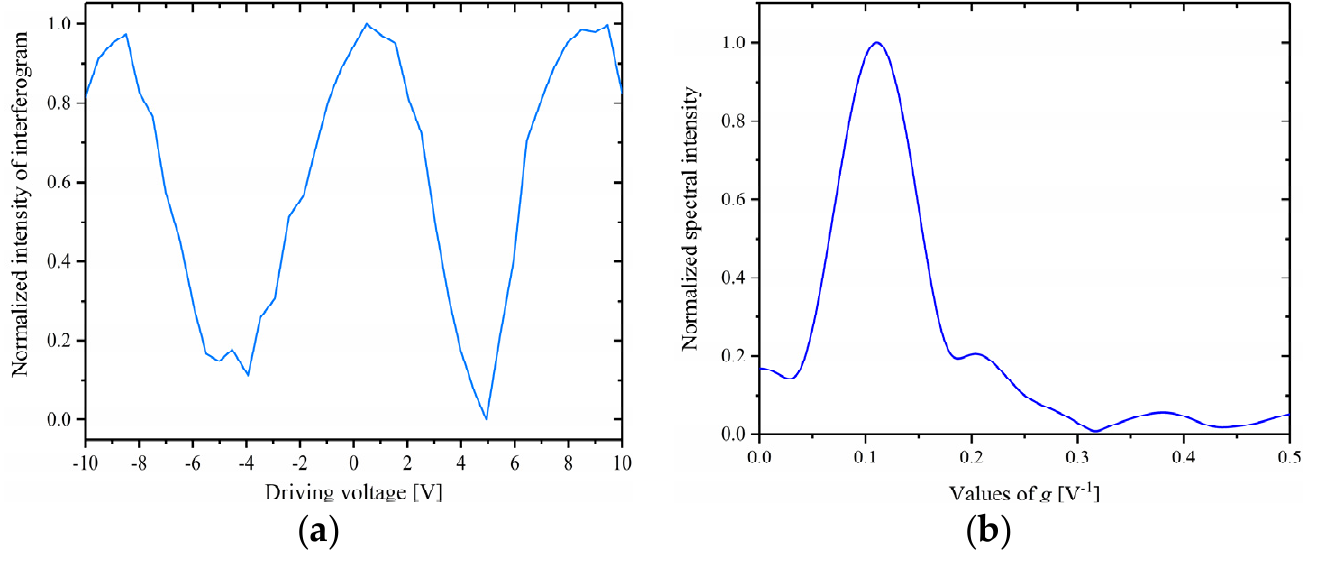
Figure 7. ( a ) The normalized intensity − versus − voltage interferogram; ( b ) The normalized spectral intensity distributed with g.